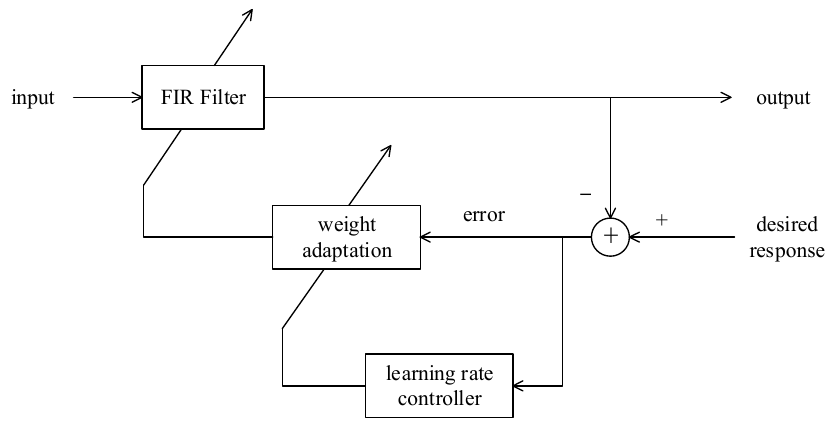
Figure 2. Block diagram of the IDBD algorithm.